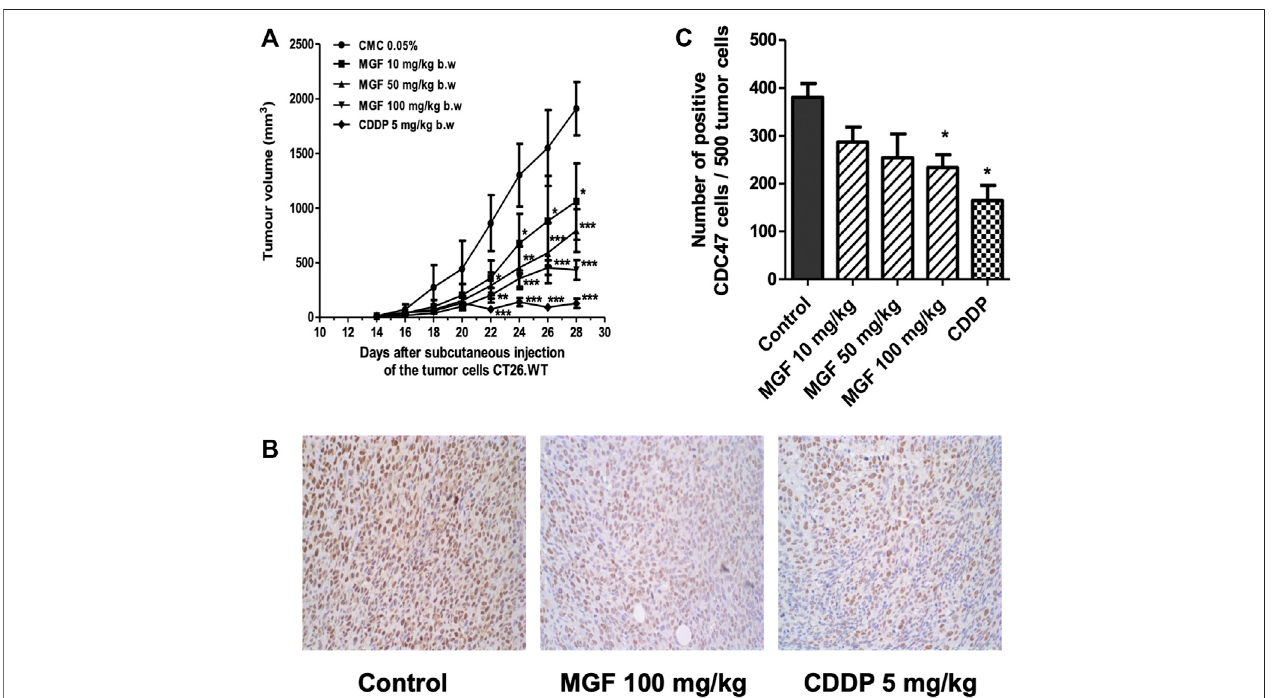
FIGURE 1 | MGF treatment induces tumor regression in CT26. WT colorectal cancer model. BALB/c mouse colorectal cancer cells CT26. WT (1 × 10 5 cells) were injectedsubcutaneouslyinto6 – 8 weeks-oldBALB/cmice.After14 daysoftumorallograftgrowth,themiceweredailytreatedfor14 daysby(oral)cannulationwithMGF at low (10 mg/ kg), intermediate (50 mg/ kg) and high (100 mg/ kg) doses or carboxymethyl cellulose (CMC) 0,05% as vehicle control. Standard chemotherapeutic CDDP treatment (5 mg/ kg) was intraperitoneal injected each 6 days. (A) Tumor volume changes induced by different treatments. (B) Immunohistochemical staining of tumor sections to CDC47 monoclonal antibody. (C) Barplot representation of quanti fi ed immunohistochemical CDC47 positive staining cells in the different experimental setups (mean ± standard error of the mean (SEM) of three independent experiments). Statistical signi fi cant differences have been determined by two-way ANOVA * p < 0.05; ** p < 0.01; *** p <